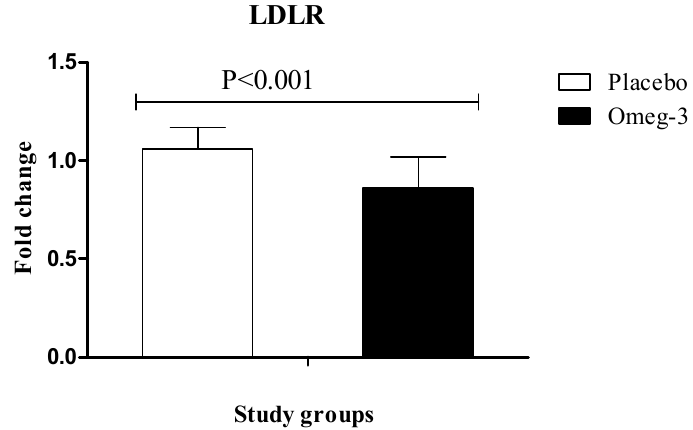
Figure 3. Effect of 6-week supplementation with omega-3 or placebo on expression ratio of LDLR gene in PBMCs of GDM women.